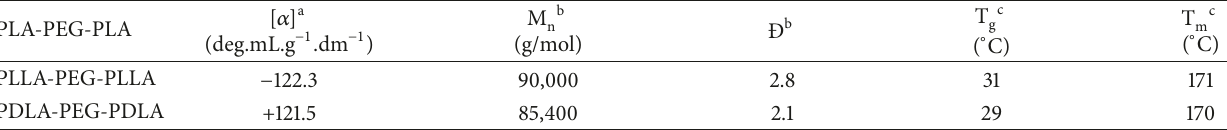
Table 1: Characteristics of PLLA-PEG-PLLA and